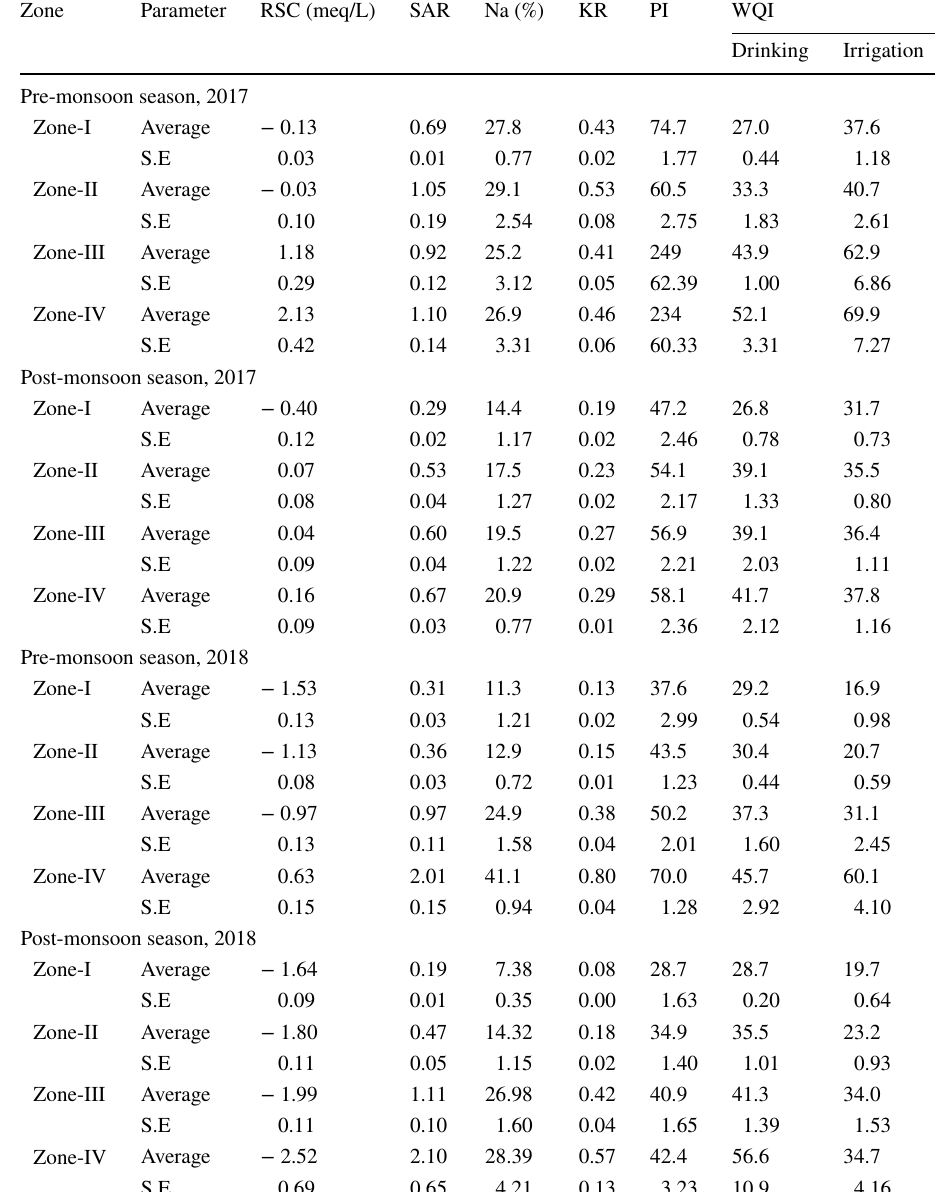
error of residual sodium carbonate (RSC), sodium adsorption ratio (SAR), sodium percentage (Na %), Kelly’s index (KI), permeability index (PI) and water quality index (WQI) of water samples collected from Sutlej river during pre-and post-monsoon seasons of the years 2017 and